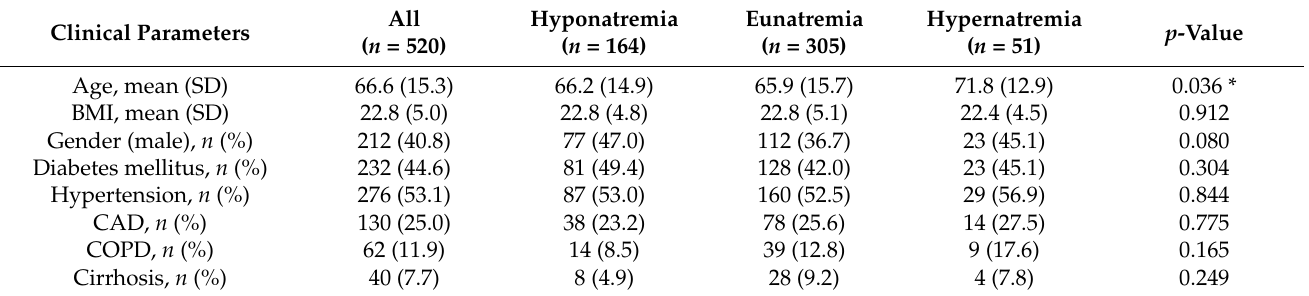
Table 1. Baseline clinical parameters and plasma cytokine levels in patients with and without dysnatremia on